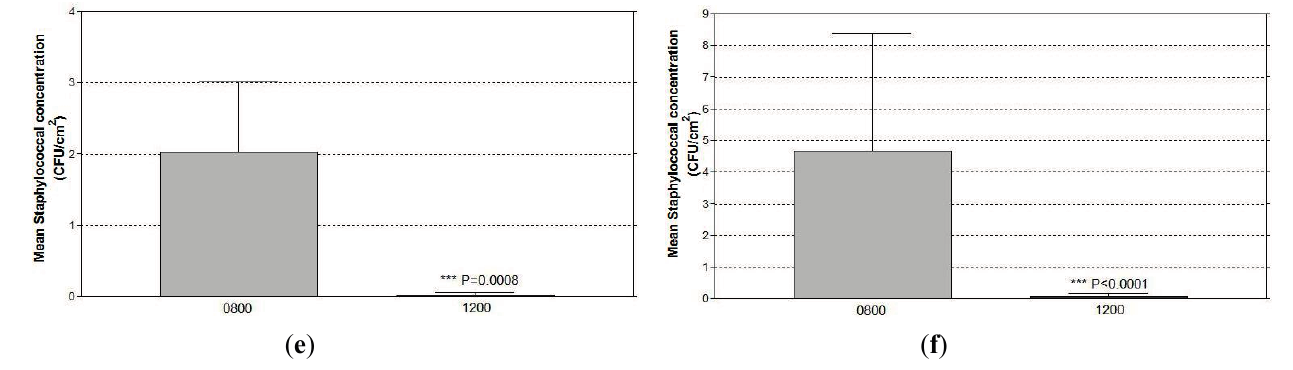
Figure 2. The increase in staphylococcal concentrations recovered from the bedside surfaces of ( a ) all control (received hypochlorite cleaning only) bed-units irrespective of the patients’ MRSA status (n = 36). ( b ) MRSA-positive patients (n = 6). ( c ) MRSA-negative patients (n = 30). The reduction in staphylococcal concentrations recovered from the bedside surfaces 4 hours after the application of JUC spray of ( d ) all bed-units irrespective of the patients’ MRSA status (n = 18). ( e ) MRSA-positive patients (n = 3). ( f ) MRSA-negative patients (n =